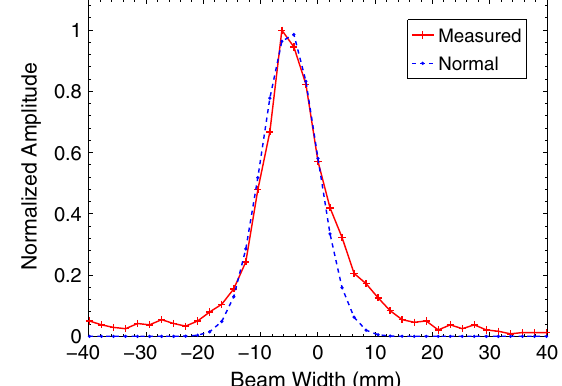
FIG. 8. Normalized transverse beam profile in the vertical plane at N 7 þ ¼ 15 (cid:7) 10 8 ions . The dotted lines show the normal distribution for the rms width obtained by evaluation of beam profile around its center.